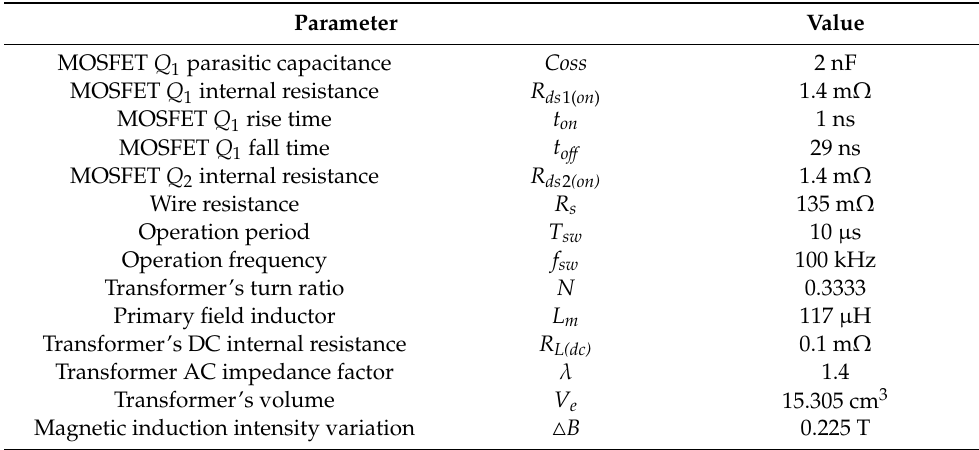
Table 2. Electrical parameters in the balancing